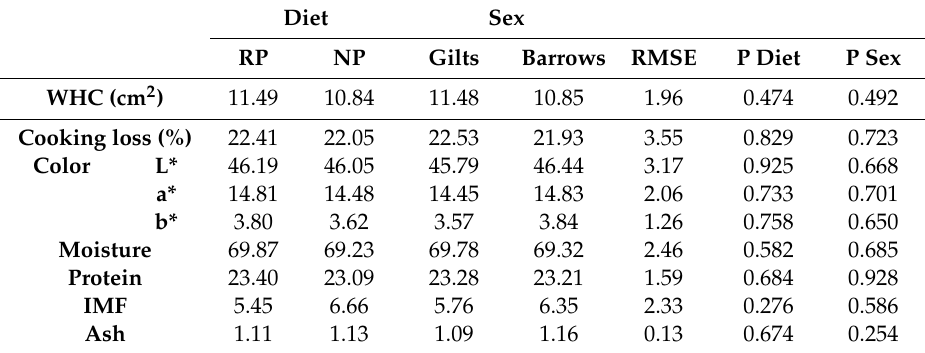
Table 4. Physical parameters and chemical composition of fresh loin (% on wet